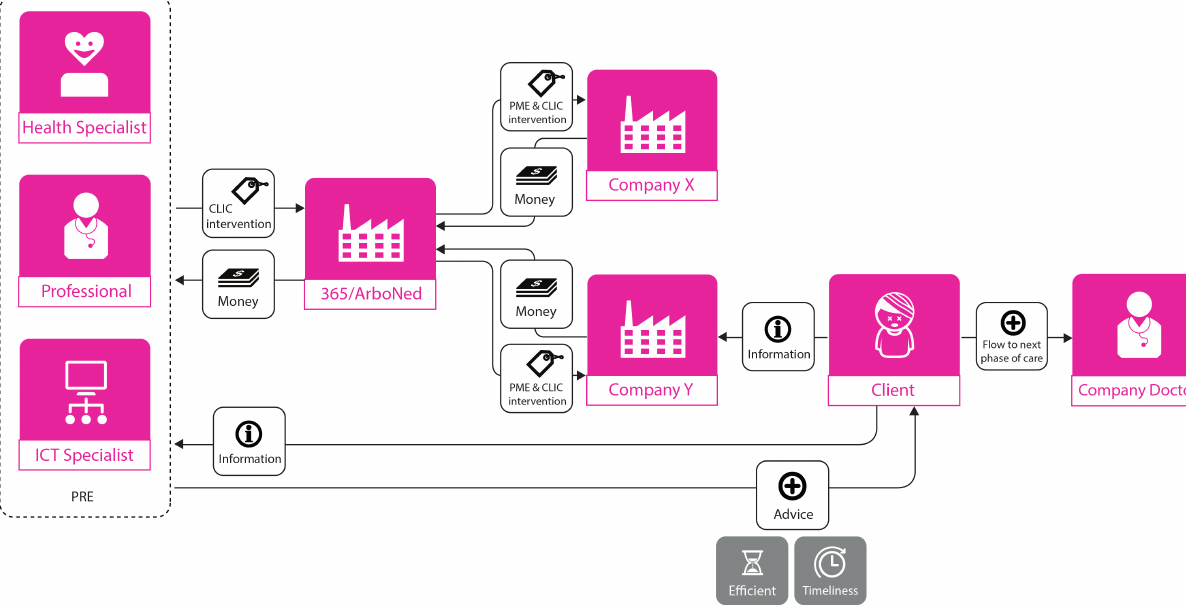
Figure 5. Business model view B from PRE (anonymized case name for the start-up organization with an online precare service for living a healthier life) health professional perspective. PME:preventive medical examinations.